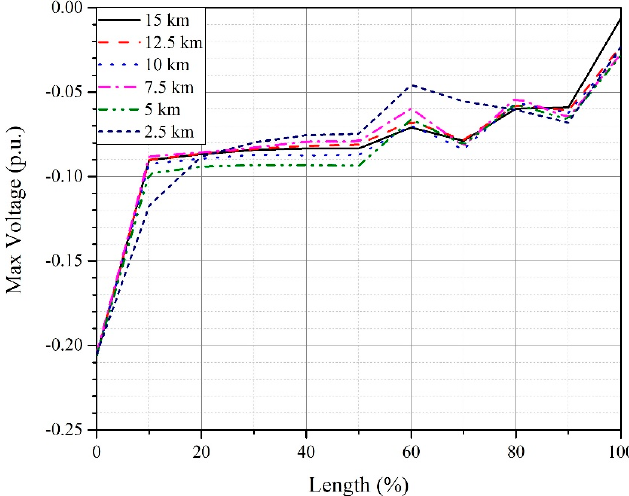
Figure 24. Sheath-ground (SG) overvoltage along the length of cable with a surge arrester installed at the terminals.